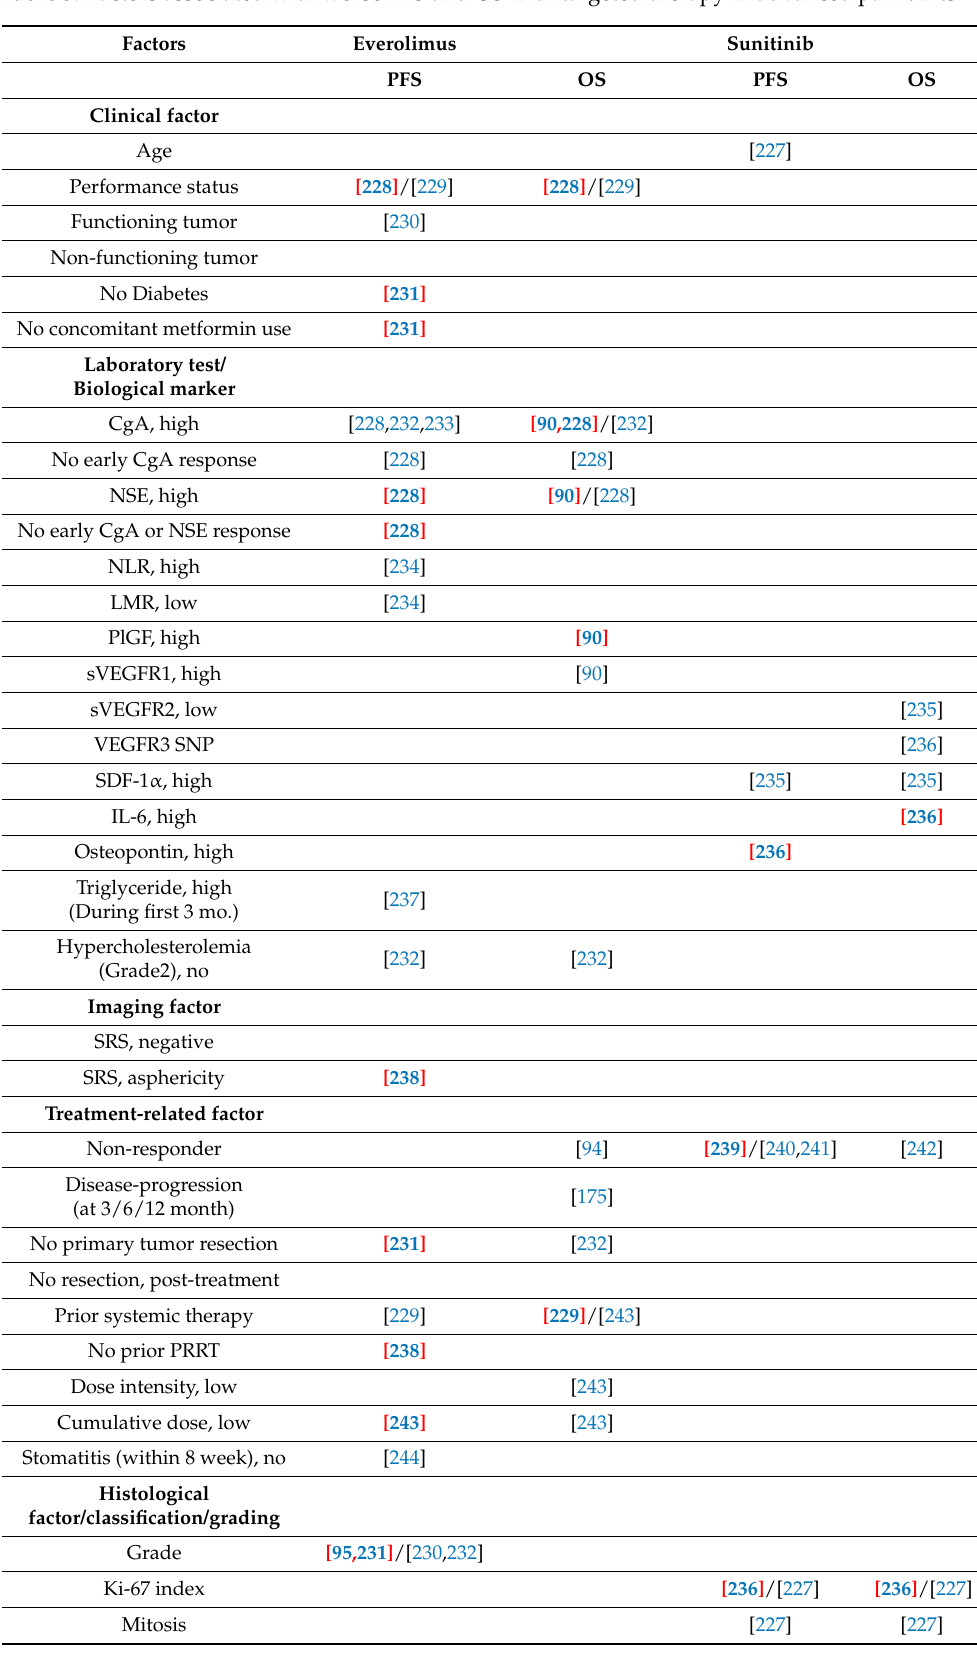
Table 3. Factors associated with worse PFS and OS with targeted therapy in advanced